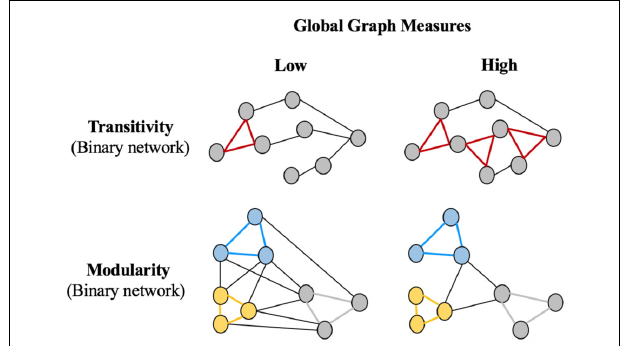
FIGURE 2 | Schematic representation of global graph measures. Circles represent nodes and edges represent connections between the nodes. The Transitivity is the number of triangles in a network, with the left panel showing a lower transitivity (one triangle), vs. the right panel showing a higher transitivity (three triangles). The Modularity panel shows that there are three modules (blue, yellow and gray), which can be less clearly divided into separate communities on the left part (high between-module connectivity relative to within-module connectivity: low modularity) than on the right part (low between-module connectivity relative to within-module connectivity: high modularity). Parentheses indicate that binary networks were used for the Transitivity and Modularity global measures. The global measures of Global Efficiency, Local Efficiency and Average Strength were also used in this study but are not represented in this Figure because they are similar to the representation in Figure 1 , but for the global network instead of the local